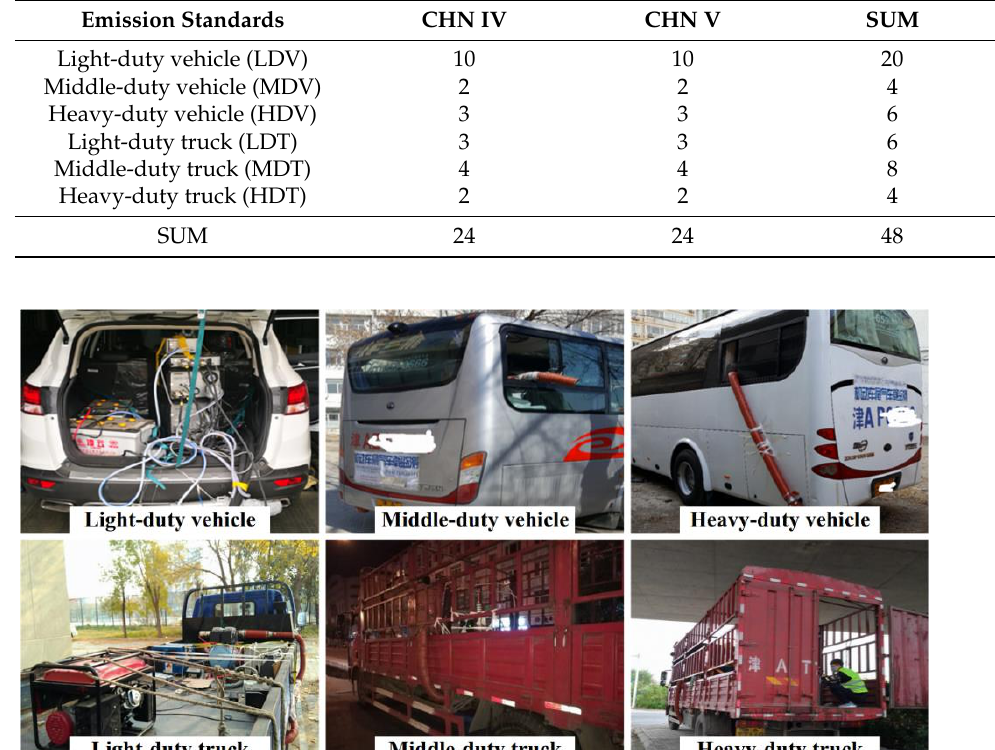
Figure 4. Part of tested vehicles equipped with